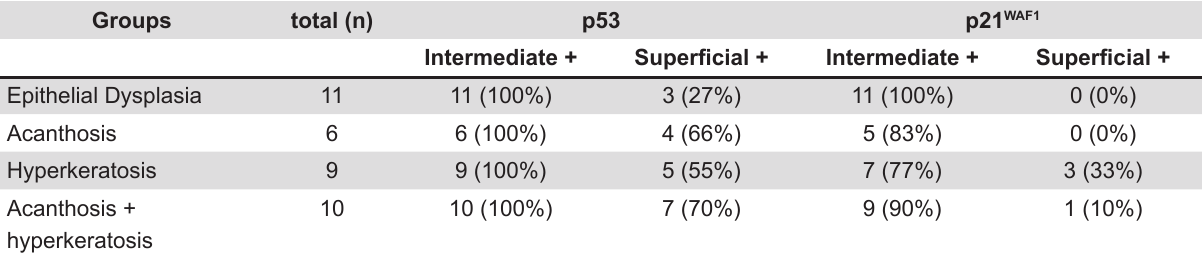
Table 4- Distribution of samples exhibiting positive p53 and p21 WAF1 staining in the intermediate and superficial